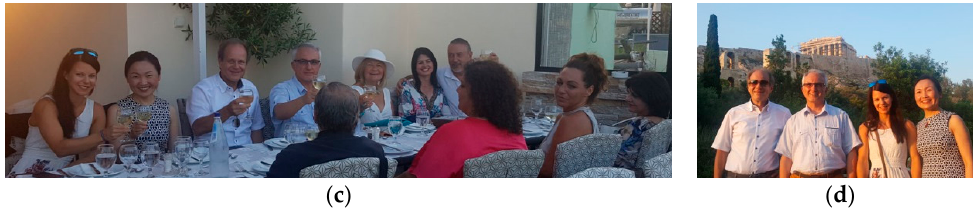
Figure 15. Interdisciplinary Acupuncture Symposium V, Athens, Greece ( a – d ). ( a ) From left to right: Dr.